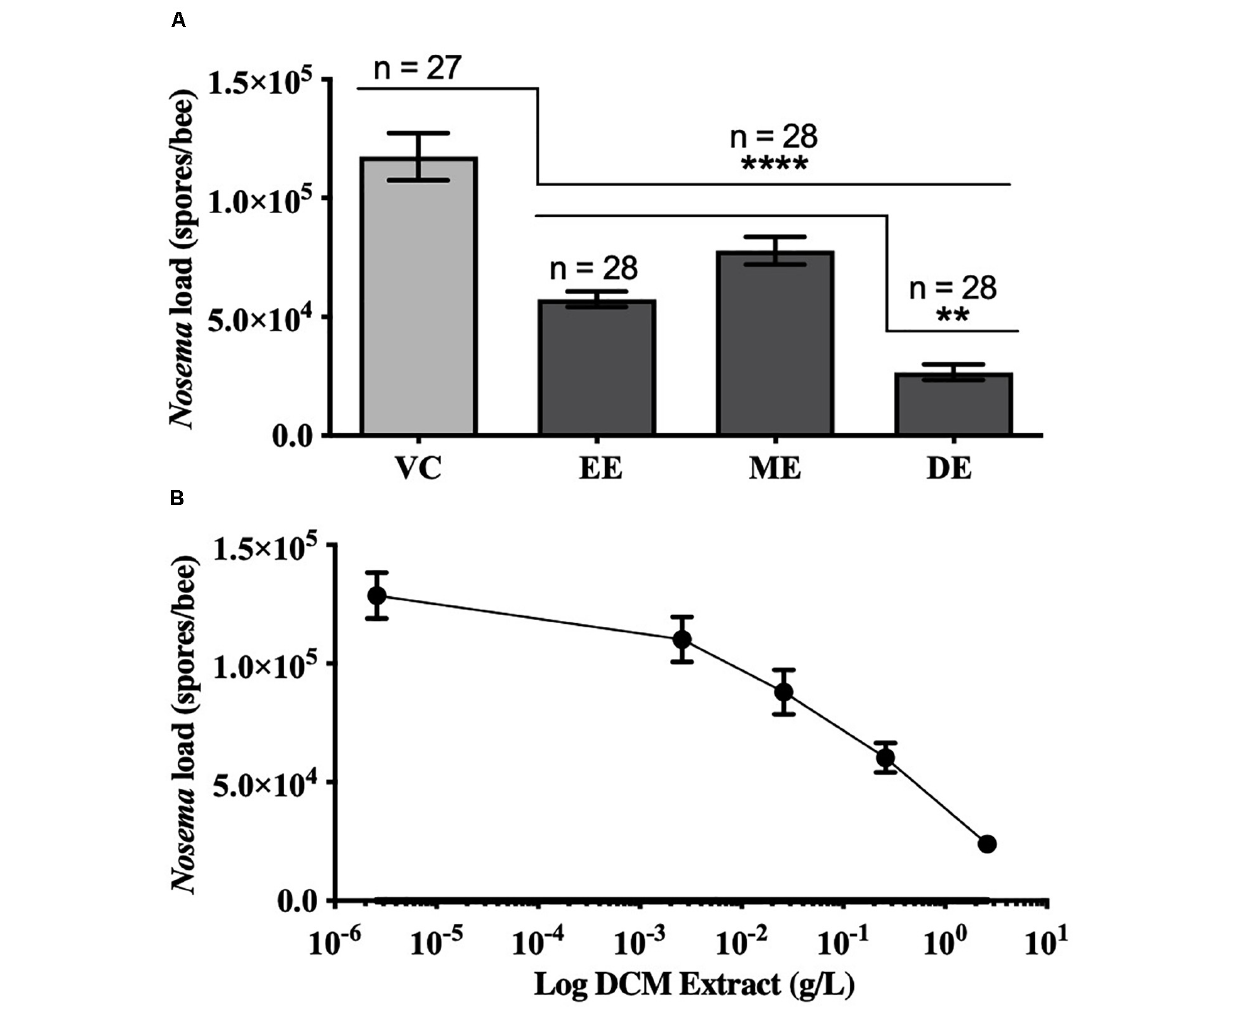
FIGURE 2 | Honey bee N. ceranae spore levels 4 days post inoculation (dpi; 2 × 10 5 spores) following feeding infected worker bees with similar concentrations of different UNYP extracts. (A) Individual bees were fed ad libitum ethanol extract (EE, 2.6 g/l), methanol extract (ME, 2.6 g/l), dichloromethane extract (DE, 2.6 g/l), or a vehicle control (VC). All values represent the mean spore load ± SEM and the number of bees in each treatment group are indicated (**indicates p ≤ 0.01 and ****indicates p ≤ 0.0001). (B) Individual bees were fed ad libitum with different concentrations of dichloromethane (DCM) extracts (10-fold dilutions of 2.6 g/l DCM extract). All values represent the mean spore load per bee ± SEM ( n = 23 bees per